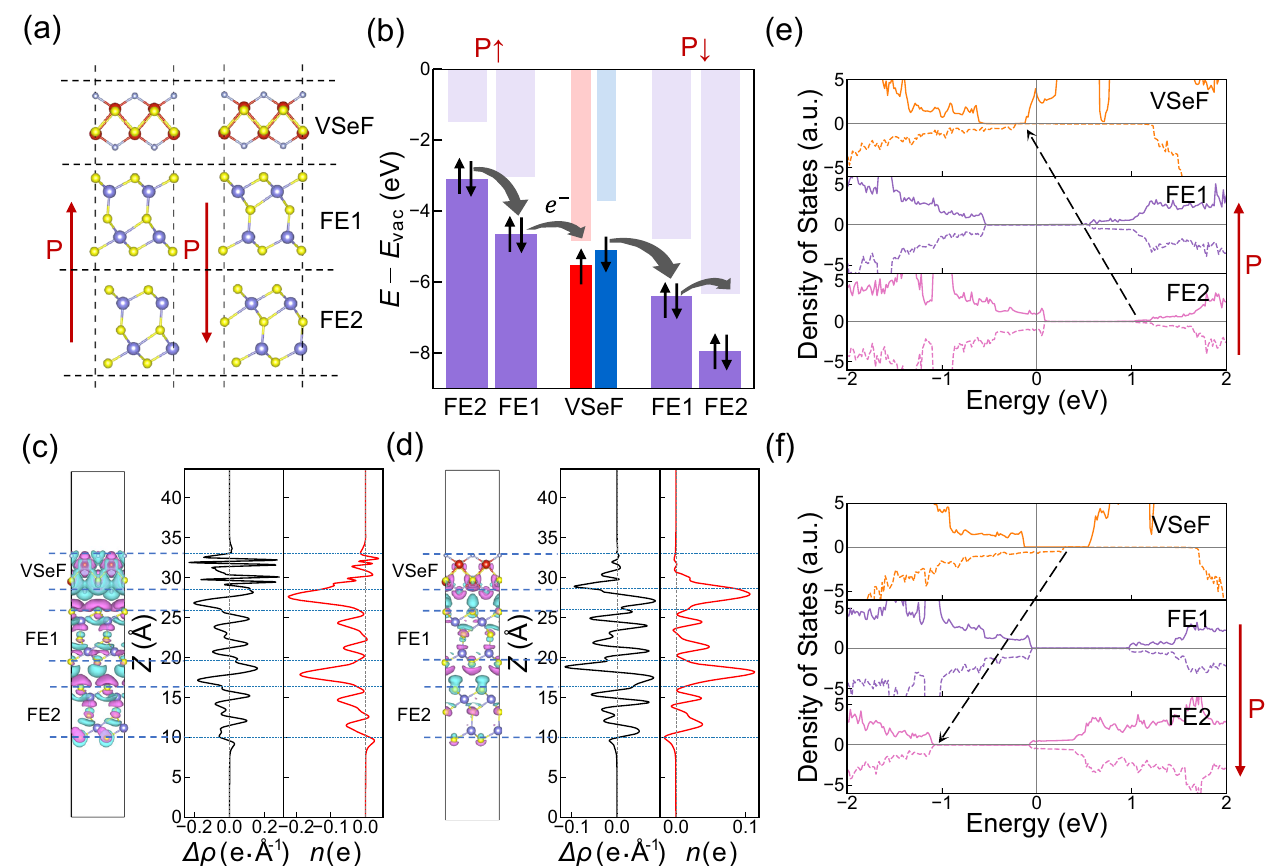
Fig. 4 VSeF/biAl 2 Se 3 trilayer heterostructures. a Side views of VSeF/biAl 2 Se 3 trilayer heterostructures. The red arrow represents the polarization direction of Al 2 Se 3 . b Band alignments of VSeF/biAl 2 Se 3 ( ↑ ) and VSeF/biAl 2 Se 3 ( ↓ ) with respect to the vacuum level of VSeF. The red and blue bars depict the band edges of spin-up and spin-down channel of VSeF, respectively. The purple bars depict the band edges of two layers of FE Al 2 Se 3 . c , d Charge density difference, planar-averaged density difference (black line) and the integral (red lines) of planar- averaged density difference along z -direction for VSeF/biAl 2 Se 3 ( ↑ ) and VSeF/biAl 2 Se 3 ( ↓ ), respectively, where the blue dashed lines indicate the atomic boundary of each layer, and the cyan and magenta isosurfaces represent electronic accumulation and depletion with isovalue of 2.03 × 10 – 3 e Å − 3 , respectively. e , f Layer-resolved PDOS of VSeF/biAl 2 Se 3 ( ↑ ) and VSeF/biAl 2 Se 3 ( ↓ ). The potential energy decreases along the direction of black dashed line. FE1 and FE2 denote the upper Al 2 Se 3 layer and the bottom Al 2 Se 3 layer, respectively. The orange, purple, and pink lines represent the PDOS contributed by VSeF, FE1, and FE2, respectively.